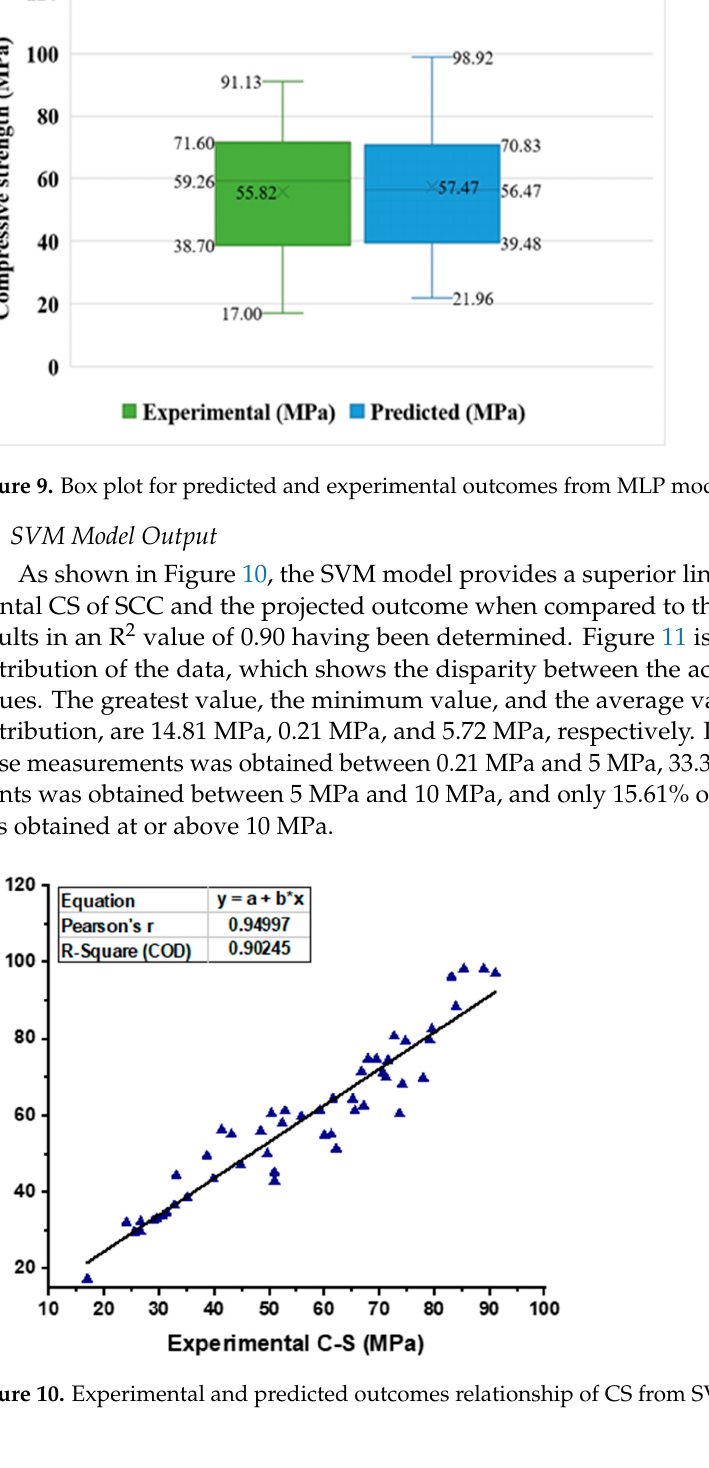
Figure 8. Indication of the error’s difference between the actual and forecasted CS result of SCC from ML model.